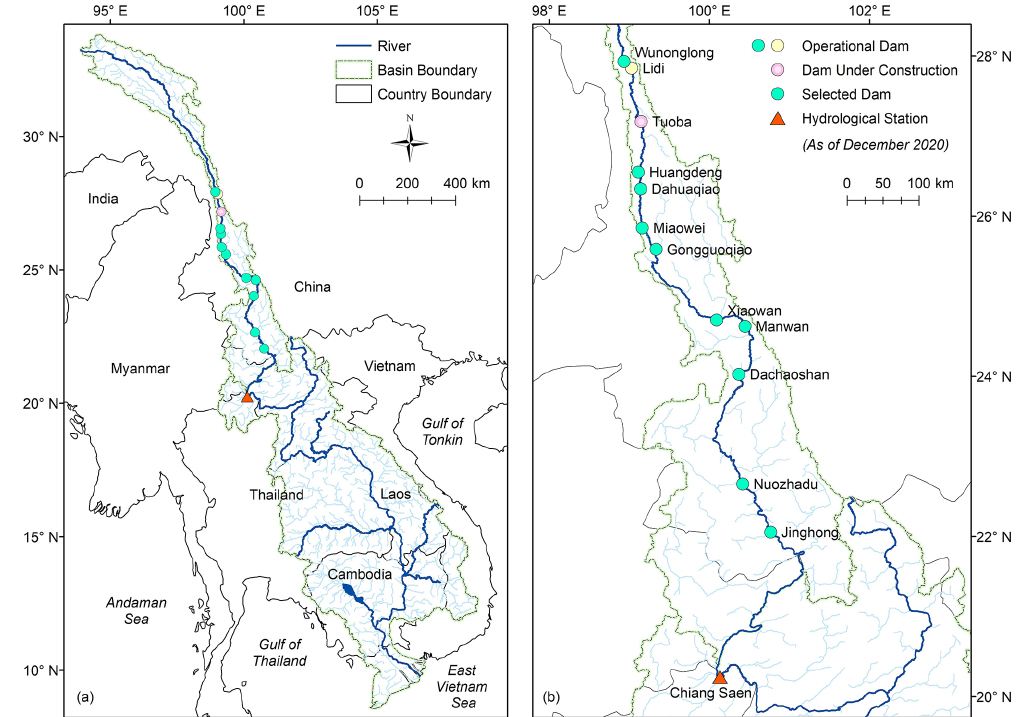
Figure 1. Mekong and Lancang River basins ( a and b , respectively). In both maps we report the location of the gauging station as well as the hydropower dams on the main stem of the Lancang. All dams were operational as of December 2020, with the exception of Tuoba, which is currently under construction. The dams analyzed in our study are denoted by a green circle.